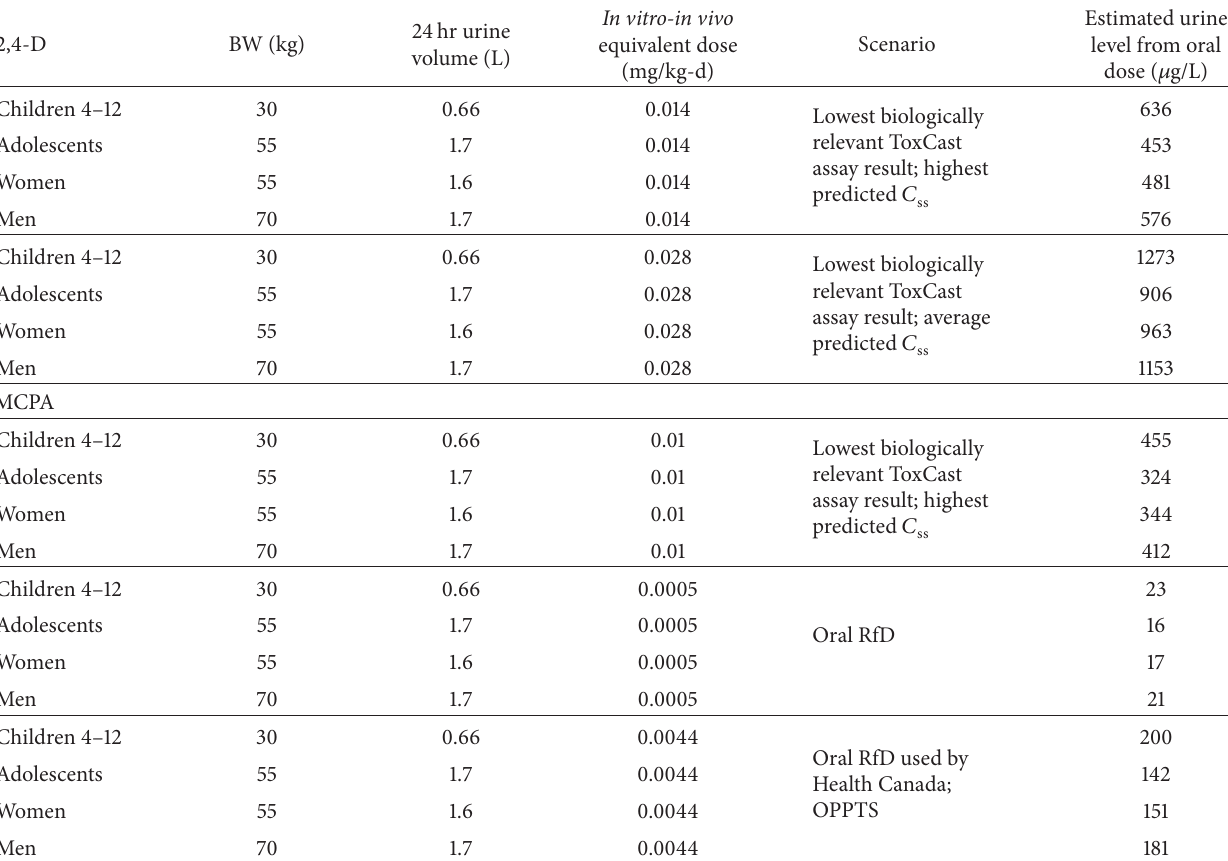
Table 11: Oral equivalent doses based on ToxCast dosimetry and estimated urinary levels associated with oral doses.